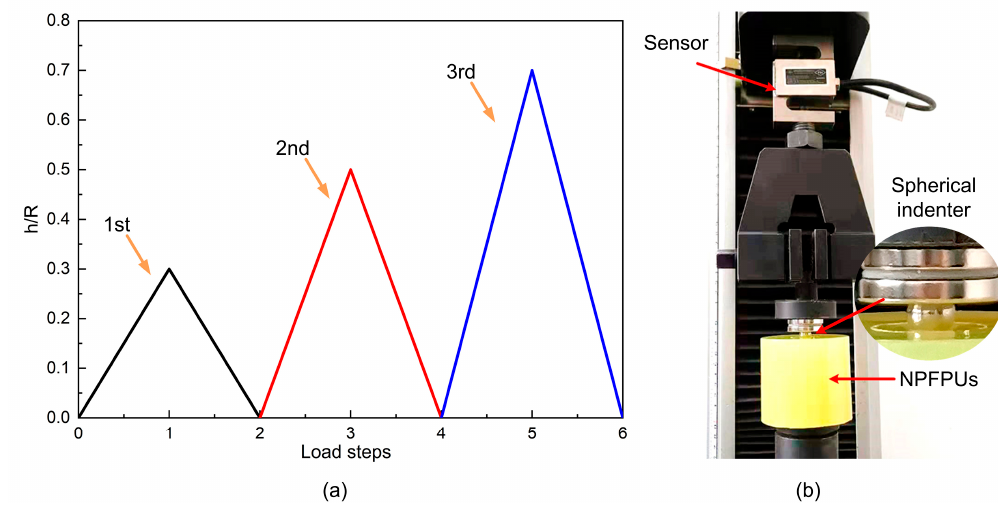
Figure 1. ( a ) Load steps in the cyclic compressive test; ( b ) Spherical indentation device.